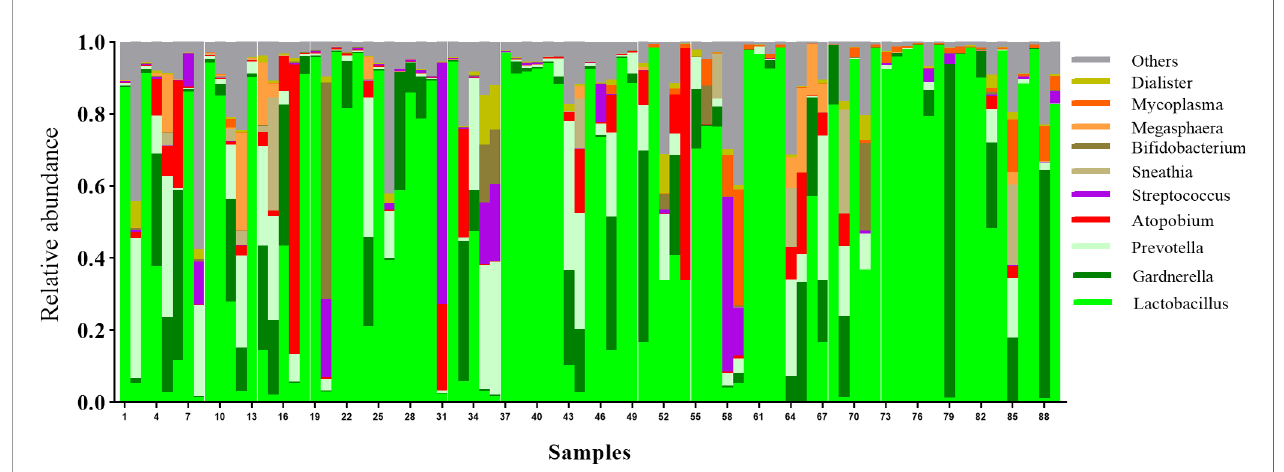
FIGURE 1 | Histogram plot for relative abundance of different genera among all